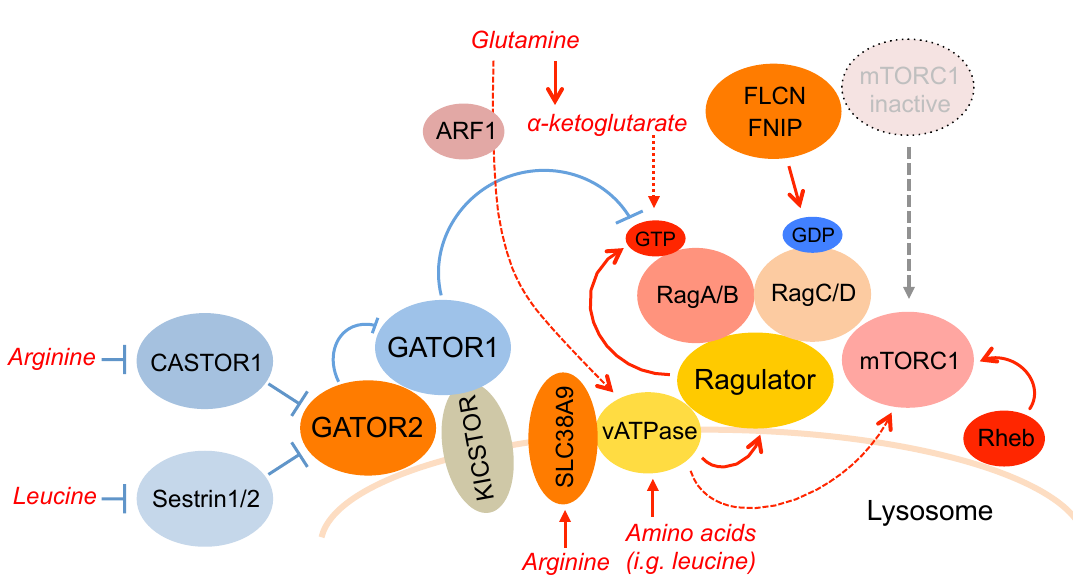
Figure 1. Amino acid-sensing mechanisms that recruit mechanistic target of mTORC1 to the lysosomal membrane. Cytosolic arginine and leucine activate GATOR2 by CASTOR1 and Sestrin1/2, respectively, leading to the inhibition of GATOR1, the GAP for the RagA/B small GTPases. Lysosomal luminal arginine activates vATPase through SLC38A9, leading to the activation of Ragulator, the guanine exchange factor (GEF) for RagA/B. Upon the activation of the Rag heterodimer, mTORC1 is recruited to the lysosomal membrane and is then activated by the small Rheb